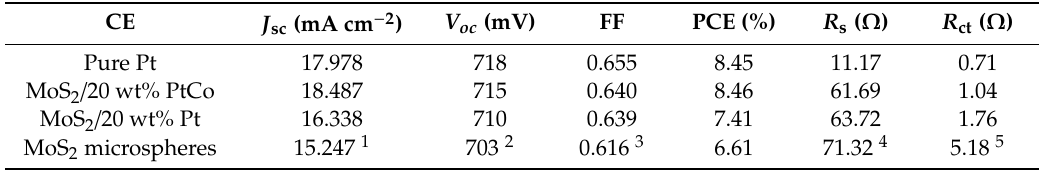
Table 1. Detailed photovoltaic parameters and EIS parameters of DSSCs based on di ff erent counter